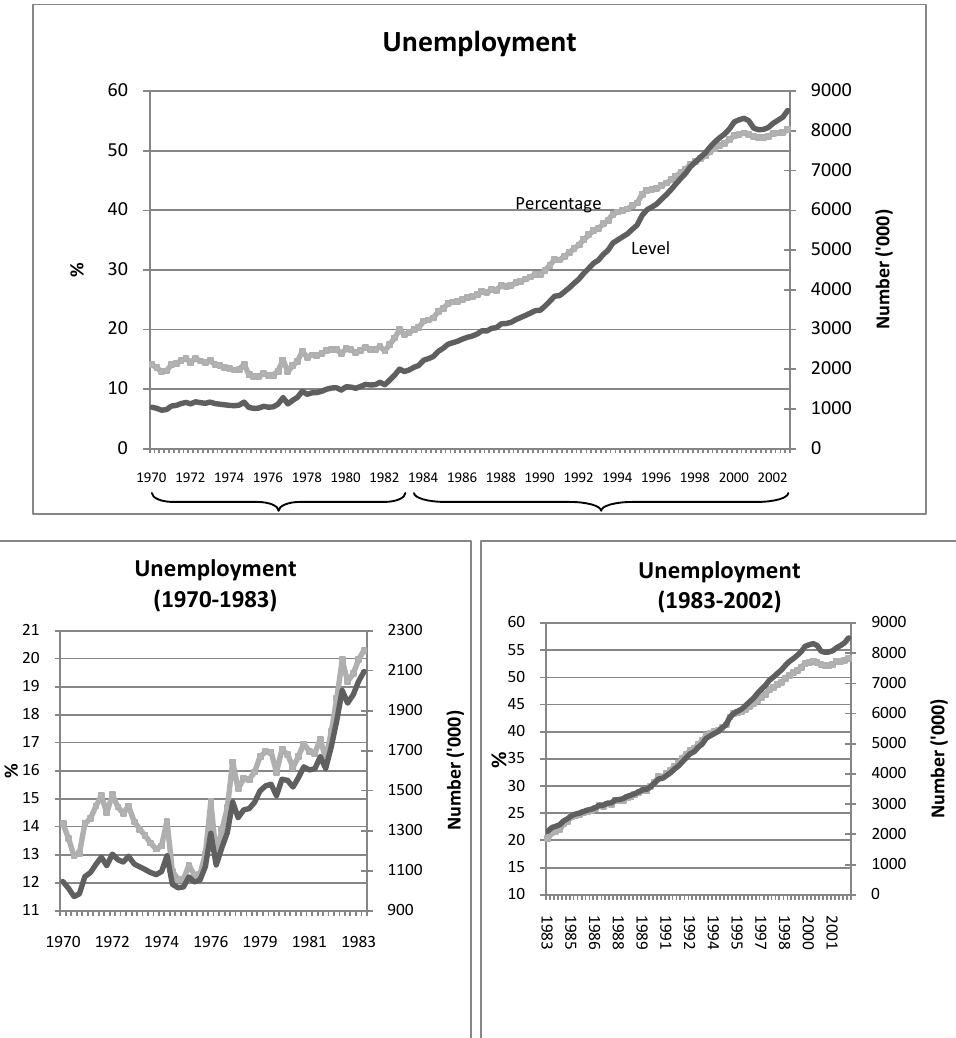
FIGURE 1: Extended unemployment in South Africa, 1970 – 2002 Source: Quantec,